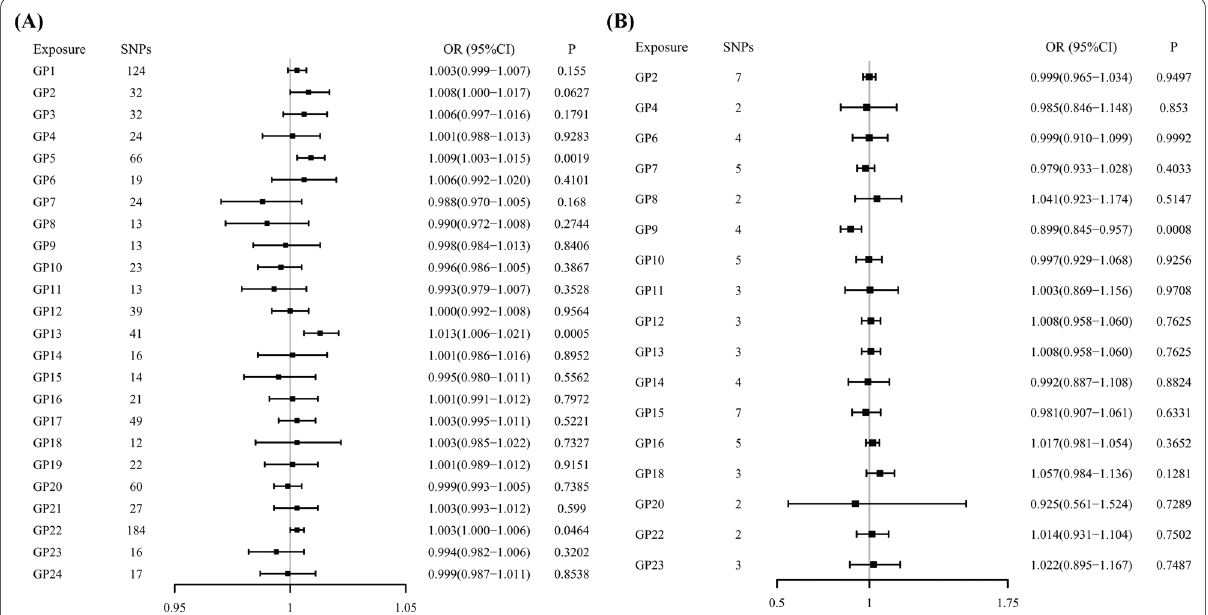
Fig. 2 Odds ratios (OR) and 95% confidence intervals (CI) of the associations between genetically determined IgG N-glycans and T2D. A in the East Asian population. B in the European population. GP glycan peak, T2D type 2 diabetes, SNP single nucleotide